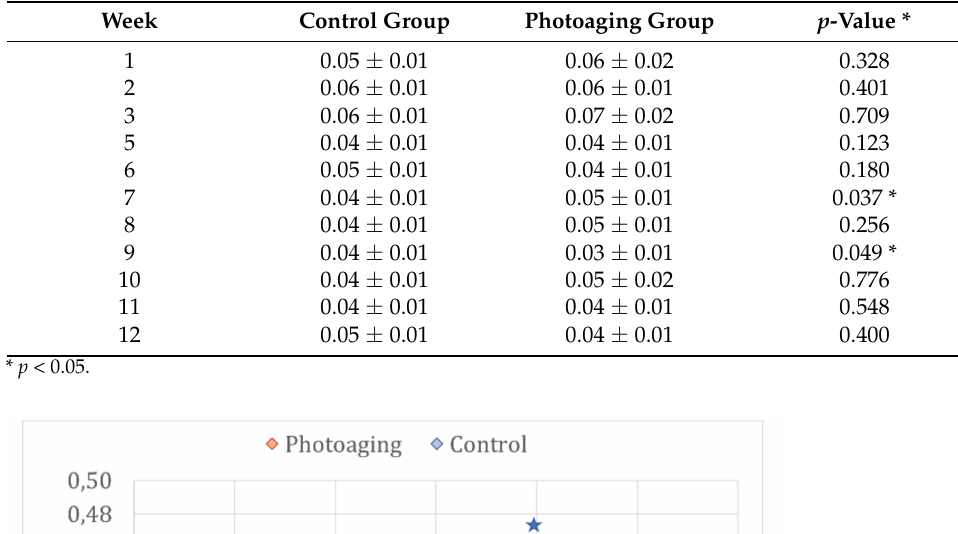
Table 1. Comparison of tissue content indices of porphyrins η porphyrins in skin tissue between animals from the control group and the photoaging group. Means and standard deviations are indicated. p -values were calculated with the Mann–Whitney test.